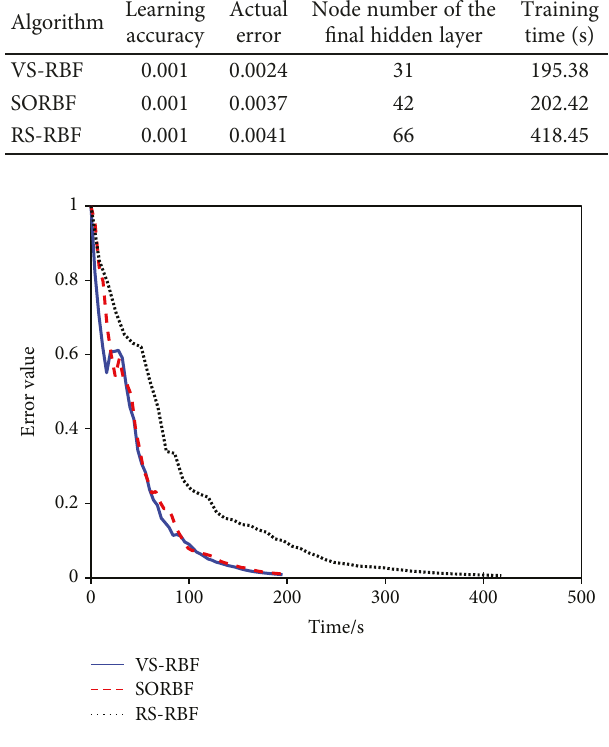
Figure 11: Error variations during